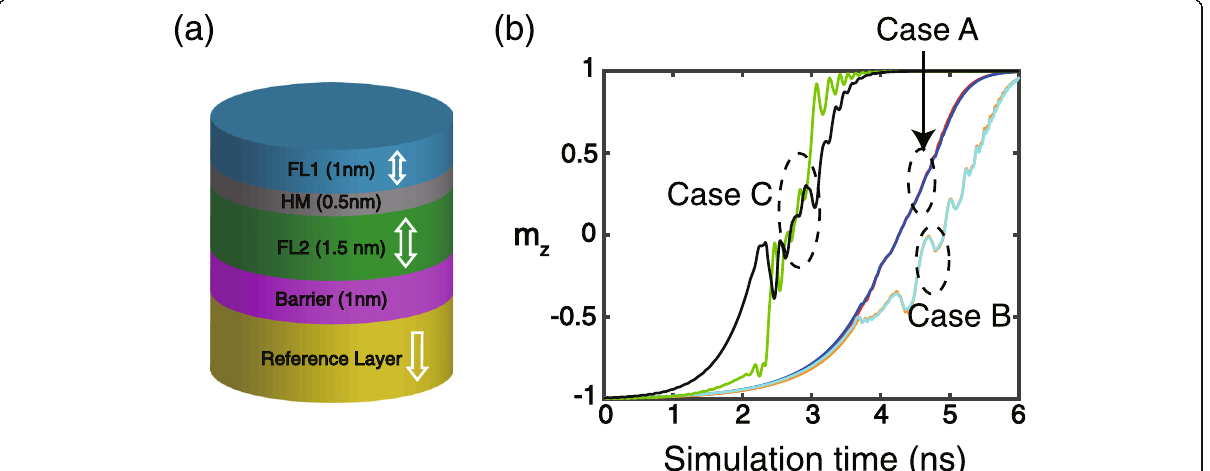
Fig. 1 a Schematic structure of the device studied in this work. The other layers are not shown for clarity. b Typical results of the time-dependent m z (perpendicular-component of the unit magnetization). Case A: σ = 1 × 10 − 3 J/m 2 , D